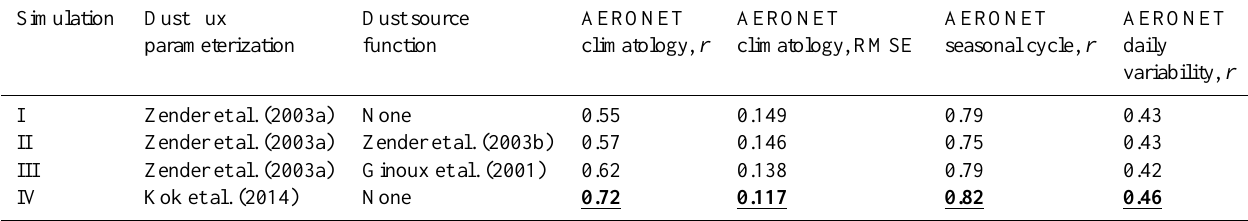
Table 1. Summary of the four CESM simulations used in this study, and the statistics of their comparisons against the data set most charac- teristic of dust emission, namely AERONET AOD measurements at dusty stations (see text). Model results are compared to measurements of AERONET AOD climatology (fourth and fifth columns), the mean correlation to the measured seasonal cycle at each station (sixth col- umn), and the mean correlation to the measured daily variability at each station (seventh column). Statistically significant improvements (see Sect. 2.4) of simulations II–IV relative to the “control” simulation I are indicated with bold font. Additionally, simulation results that are statistically significantly improved over the results of each of the other three simulations are both bold and